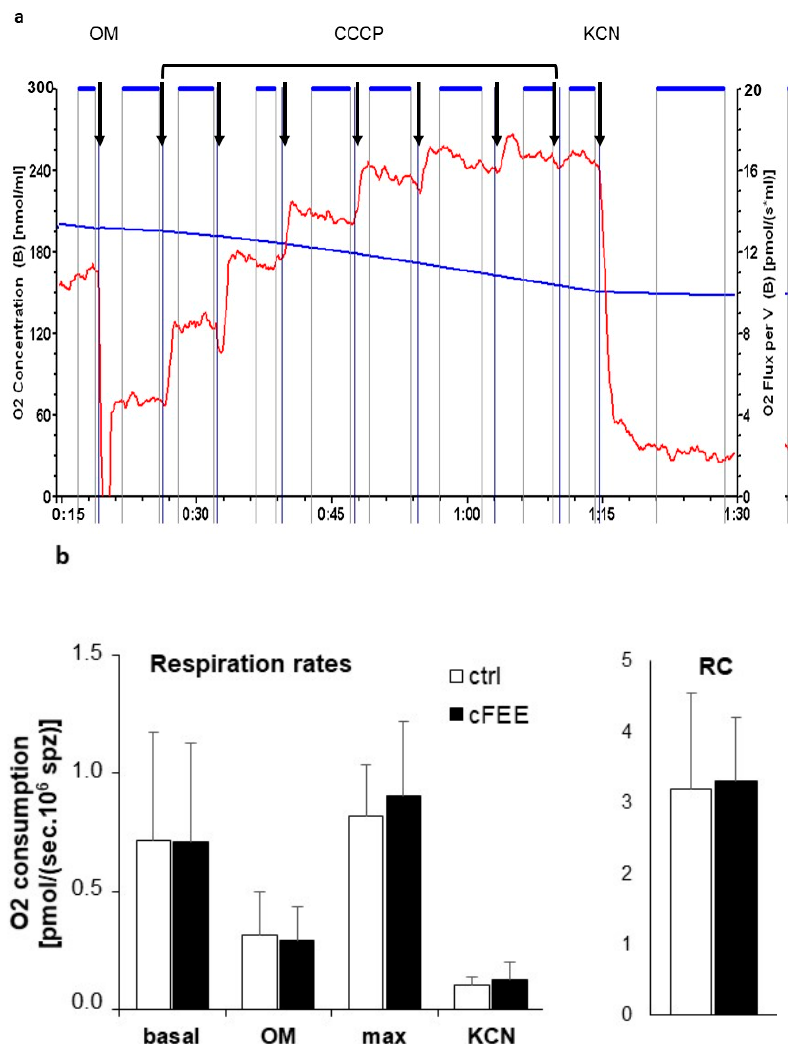
Figure 3. cFEE impact on sperm respiration. ( a ) Representative respiration analysis using Oroboros instrument; sperm concentration was 17.5 × 10 6 spermatozoa/mL; black arrows = successive additions into Ferticult; OM = 1 µ M oligomycin; CCCP = 1.25 µ M CCCP; KCN = 1 mM KCN; horizontal blue lines between arrows represent periods chosen for calculation of the rate of oxygen consumption; blue curve with values in nmol per milliliter in the left axis = oxygen concentration in the medium; red curve with values in pmol per second and milliliter in the right axis = rate of oxygen consumption. ( b ) cFEE had no impact on sperm respiration parameters; ctrl = 7 independent sperm preparations from healthy donors after 3-h incubation without cFEE; cFEE = same samples but incubated in the presence of 100 µ M cFEE; respiration rates are expressed as pmol O 2 consumed per second and million sperm (pmol/(sec.10 6 sperm)); Basal = respiration in basal conditions; OM = respiration after the addition of oligomycin, an inhibitor of ATP synthase, measuring the respiration rate not producing ATP; max = maximal respiration level obtained after successive additions of 1.25 µ M CCCP, a protonophore dissipating the inner mitochondrial membrane potential; KCN = oxygen consumption after addition of